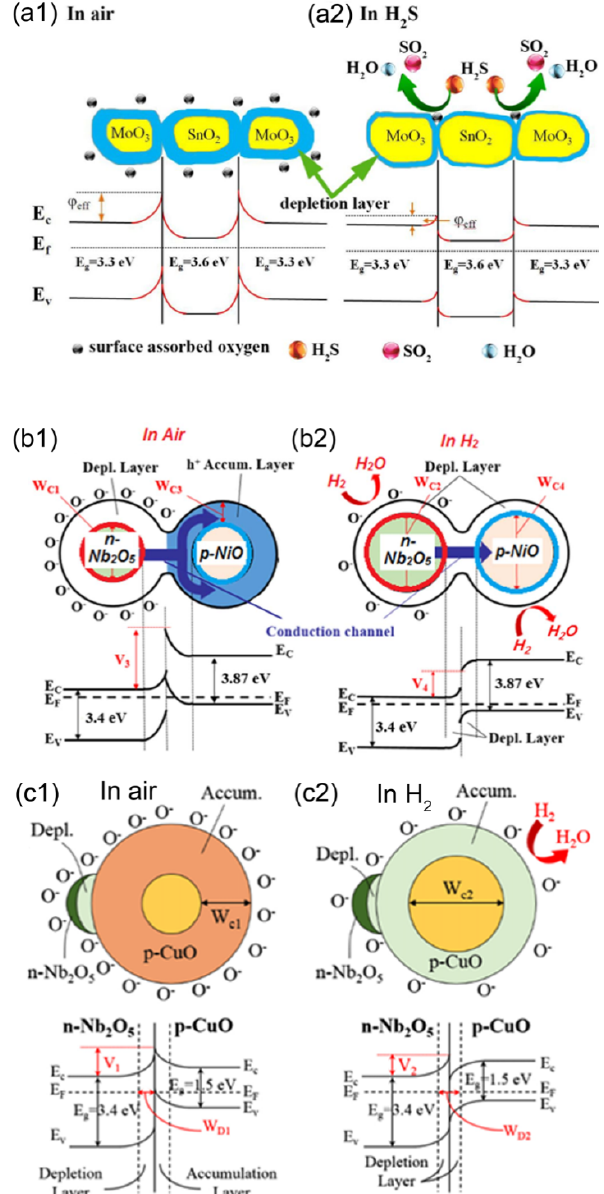
Figure 7. The enhanced gas sensing mechanisms of ( a1 , a2 ) MoO 3 /SnO 2 nanoflakes (n-n heterojunc- tion) (Copied with permission [120]. Copyright 2019, American Chemical Society.), ( b1 , b2 ) NiO- Nb 2 O 5 composite nanoparticles (n-p heterojunction) (Copied with permission [123]. Copyright 2017, Elsevier.) and ( c1 , c2 ) Nb 2 O 5 nanoparticle-decorated CuO nanorods (p-n heterojunction) (Copied with permission [119]. Copyright 2017, Springer Nature.) to reducing gases.